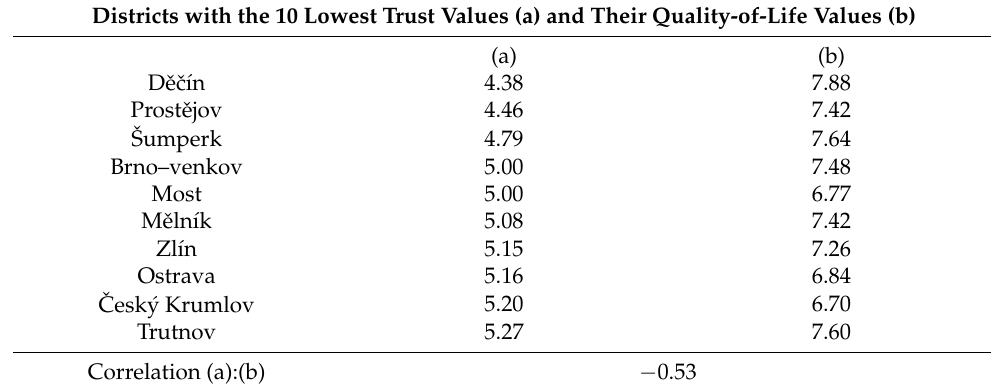
Table 7. Districts with the lowest values of trust and corresponding quality-of-life values. Districts with the 10 Lowest Trust Values (a) and Their Quality-of-Life Values